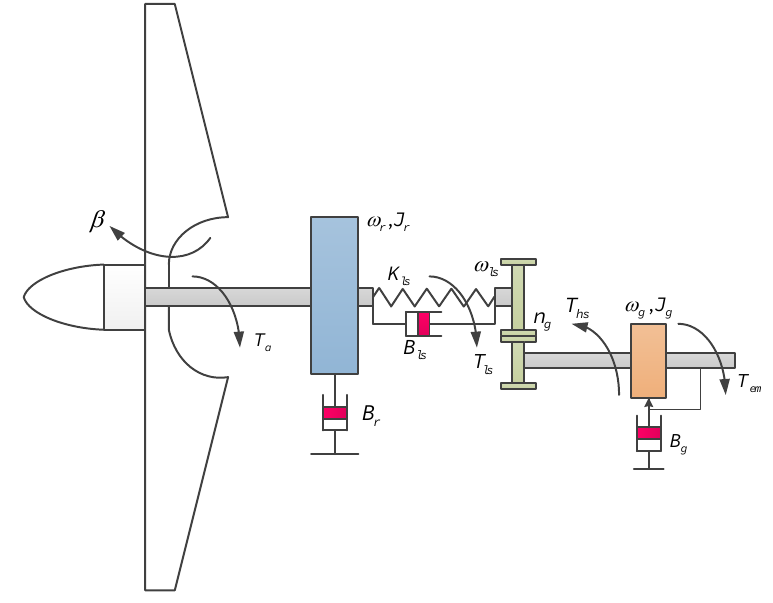
Figure 1. Wind turbine